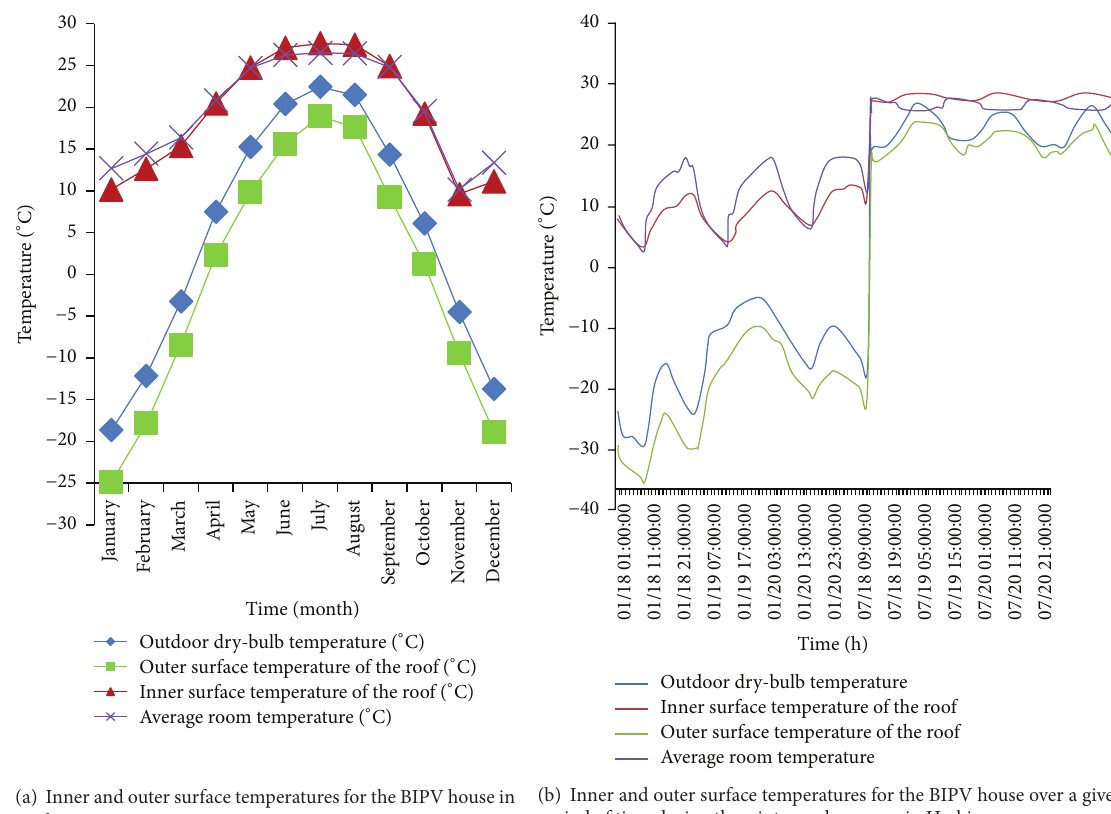
Figure 13: Simulated inner and outer surface temperatures for the BIPV house in